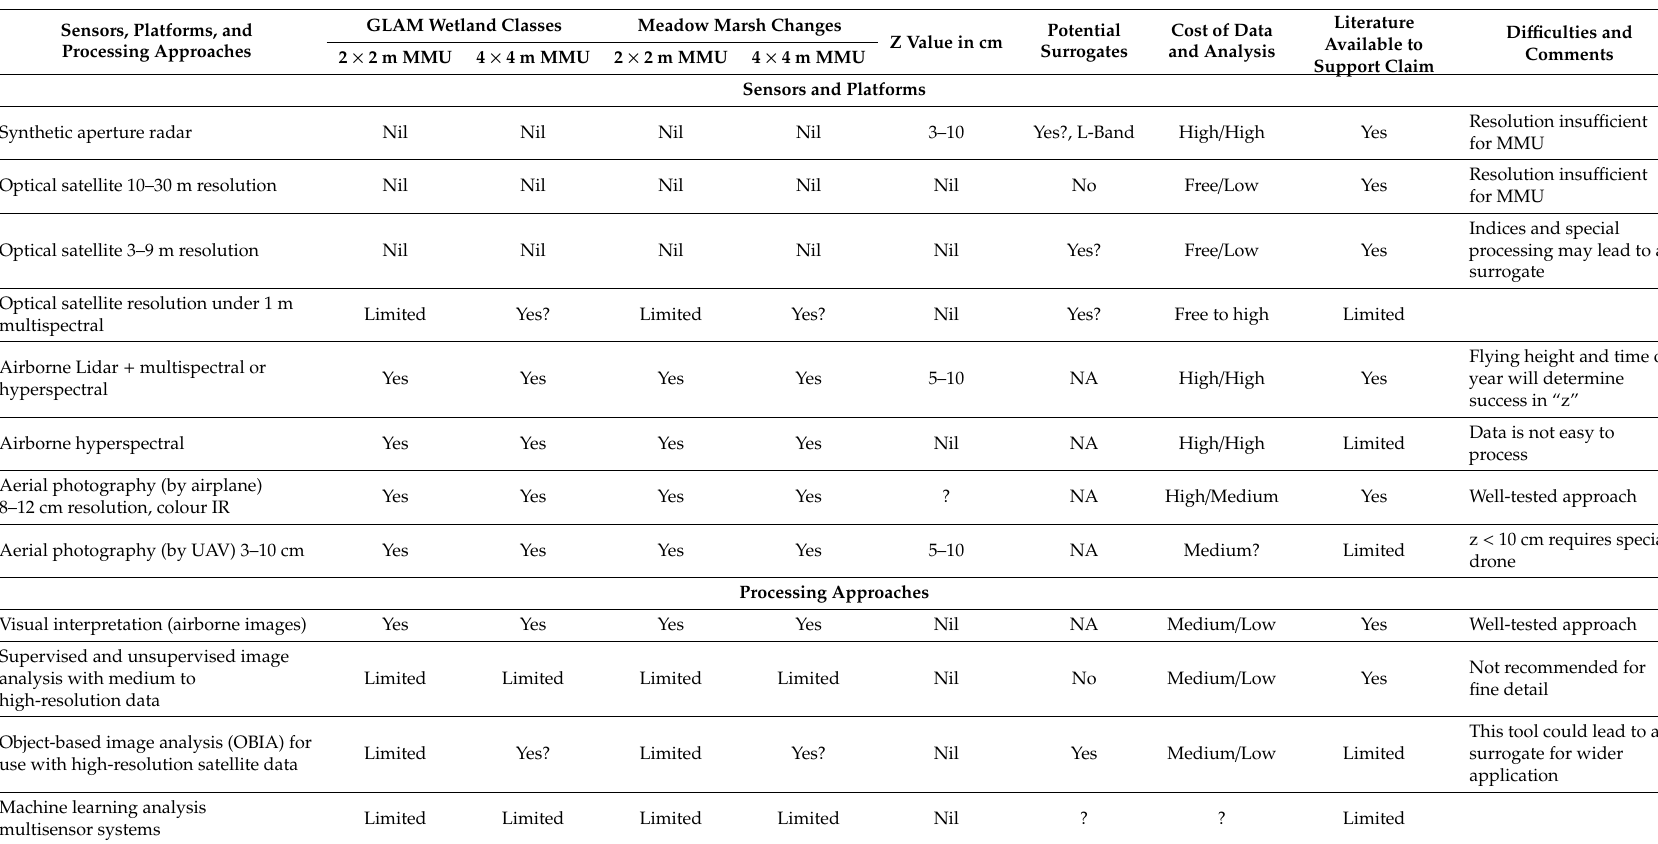
Table 3. Summary of the systems and sensors to meet the requirements of the Great Lakes St. Lawrence Adaptive Management (GLAM) Committee. Nil indicates that the system or sensor would be unlikely to deliver the required accuracy given the minimum mapping unit (MMU). The Z value refers to vertical